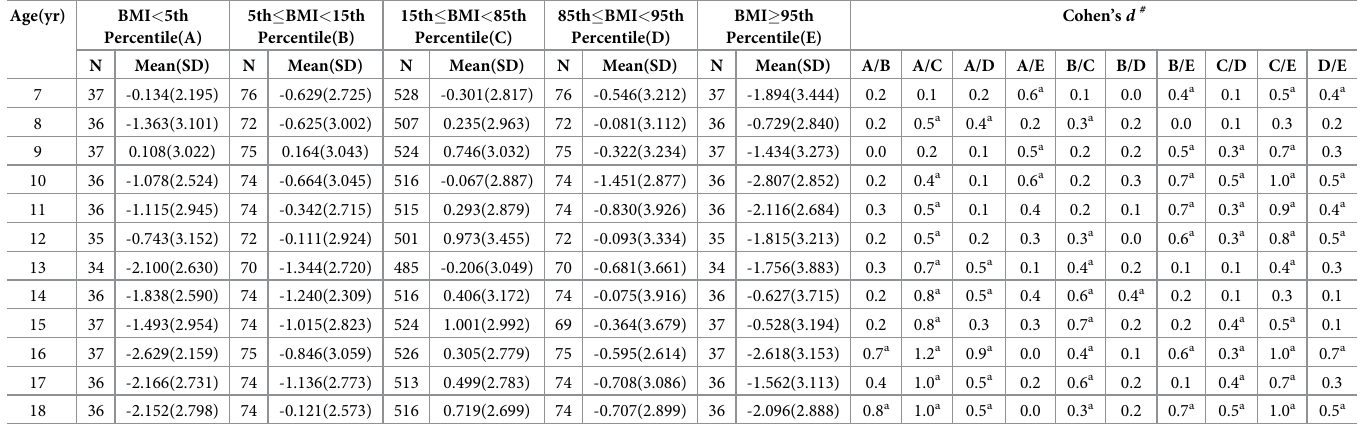
Table 3. Comparisons of physical fitness index among boys in different body mass index and age groups.